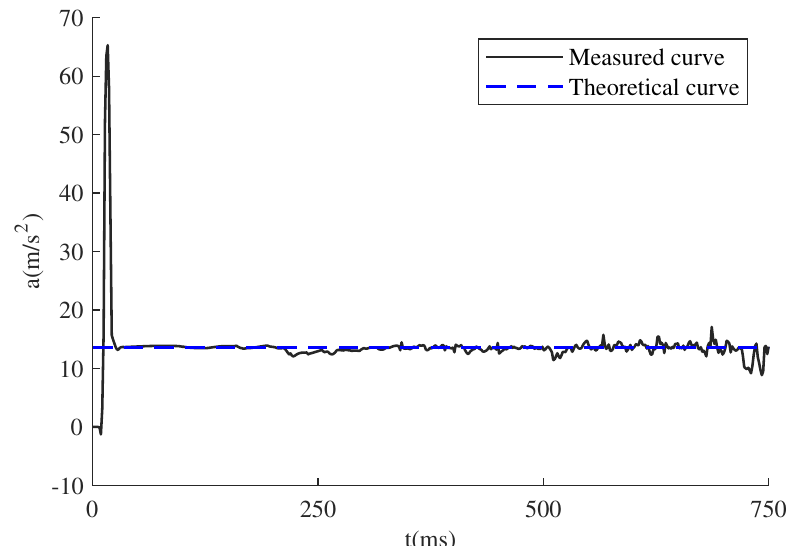
Figure 8. Acceleration–time curve of the non-slip